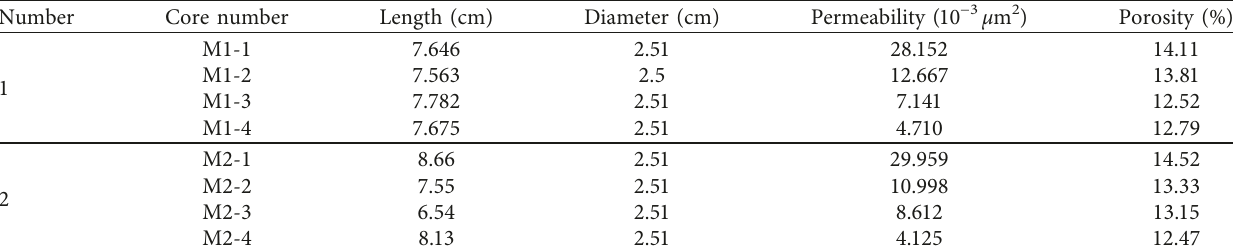
Table 1: Physical parameters of the core samples.